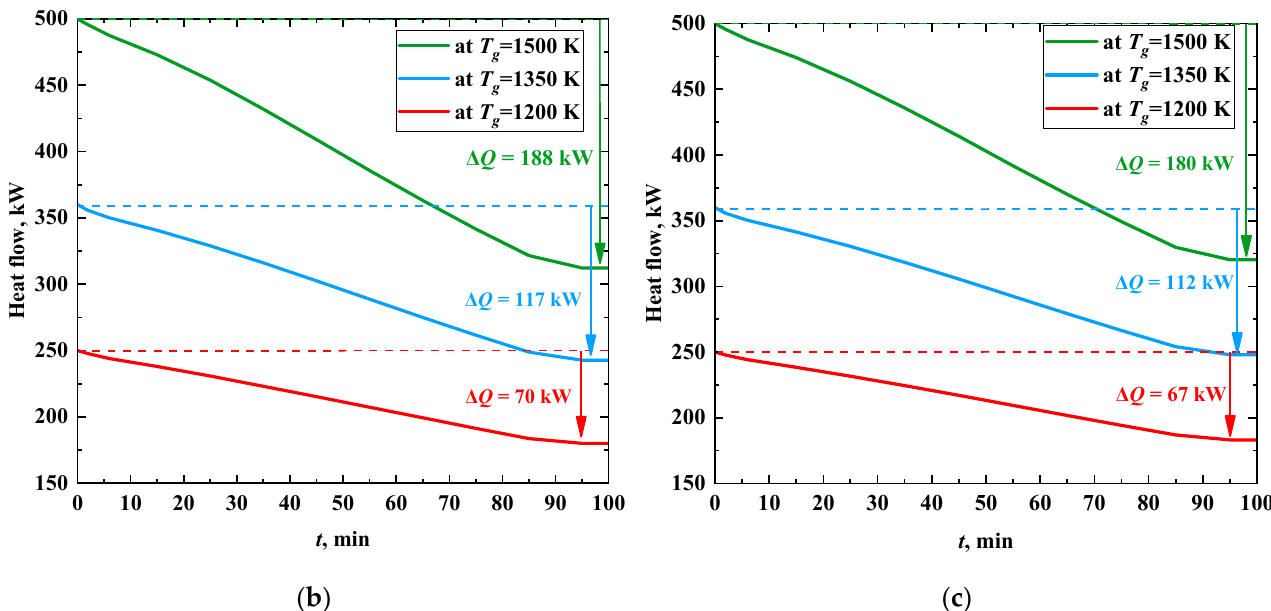
Figure 11. Time change of heat flux to a water coolant when burning different fuels: ( a ) coal, ( b ) CWS, ( c ) CWSP.